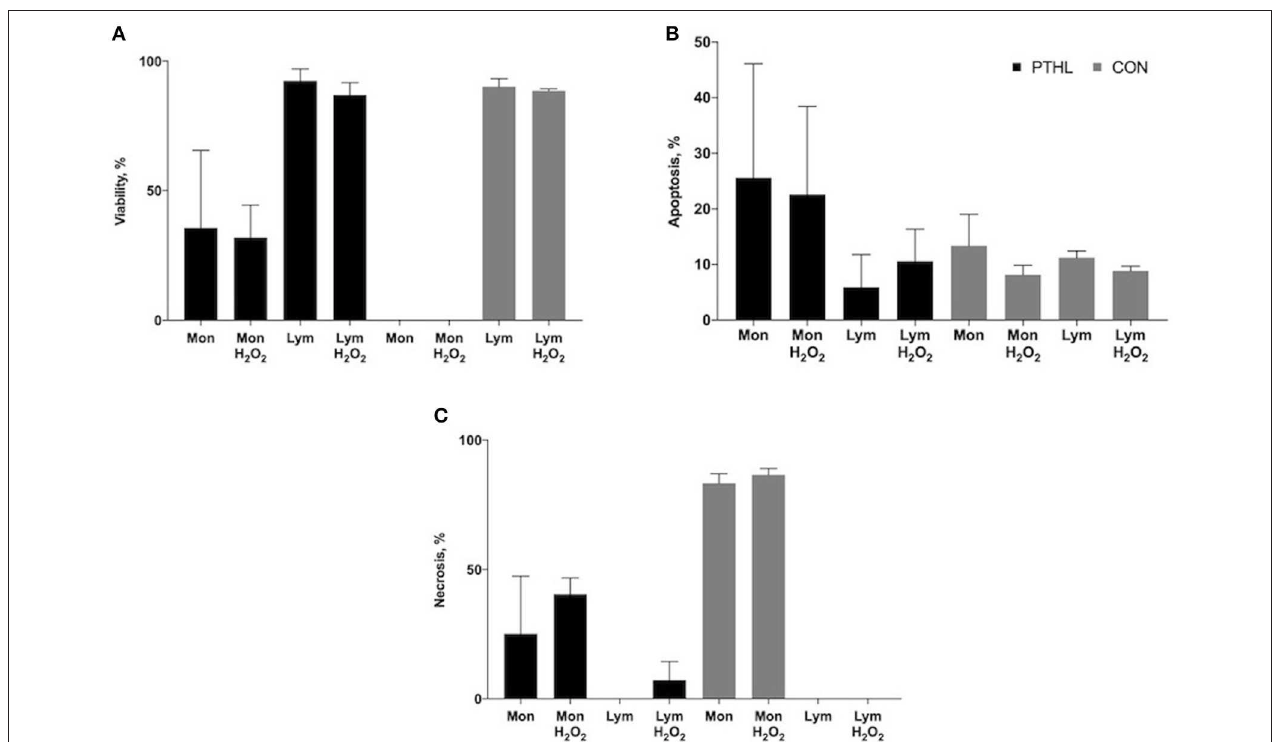
FIGURE 3 | Percentage of viability (A) , apoptosis (B) and necrosis (C) of monocyte/lymphocyte stained with supravital exposure to propidium iodide (PI, 50 µ g/mL). Cells (1 × 106) were pretreated with LPS and ConA (1 µ g/mL and 5 µ g/mL, respectively) and with H 2 O 2 (4 mM) for 1h, then stained with PI for 30 min at the dark and washed before flow cytometric analysis. The supravital PI exposure on unfixed cells allowed to the simultaneous detection of living (PI negative) apoptotic (PI dim) and necrotic (PI bright)